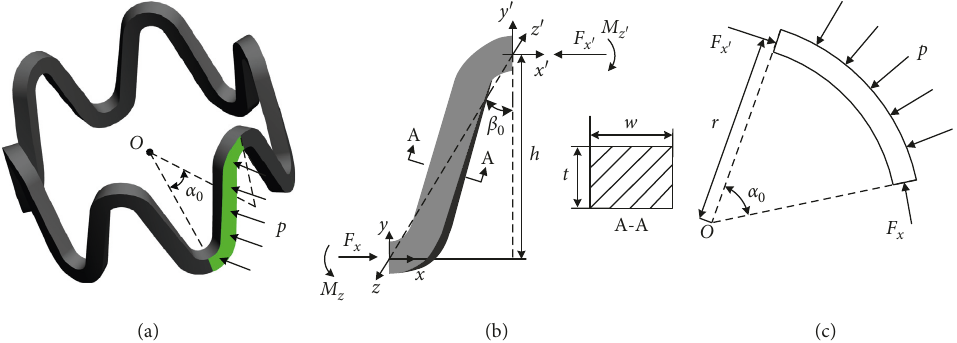
Figure 2: Diagram of supporting ring under external pressure: (a) the supporting ring; (b) the front view of the semisupporting element; (c) the axial view of the semisupporting